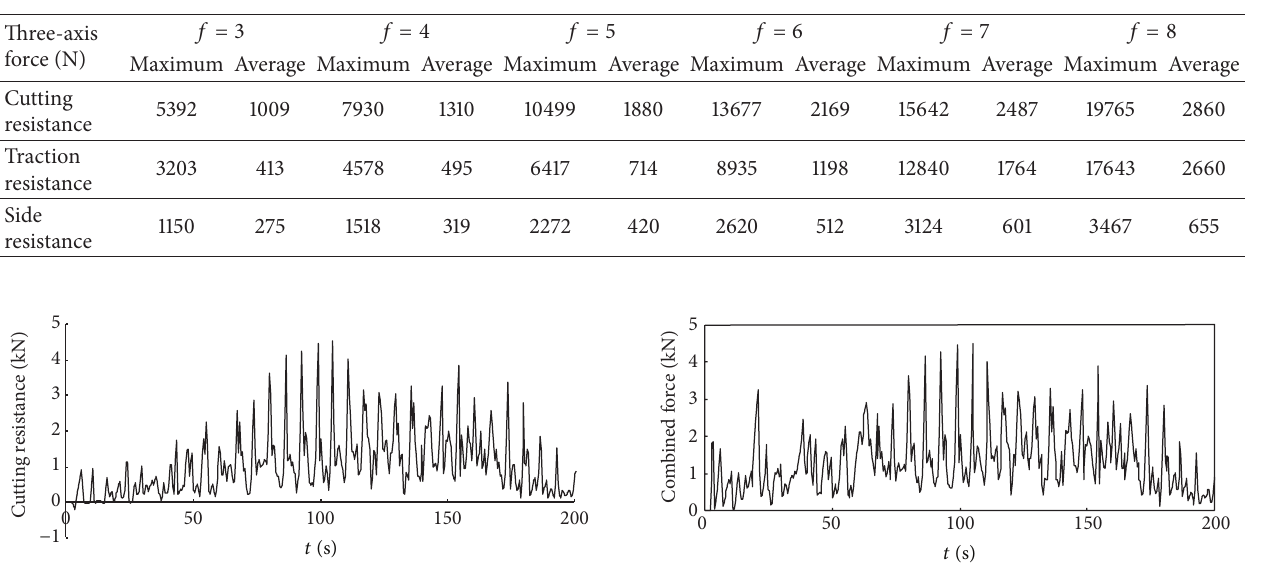
Table 3: Load statistics of cutting process with a single pick.